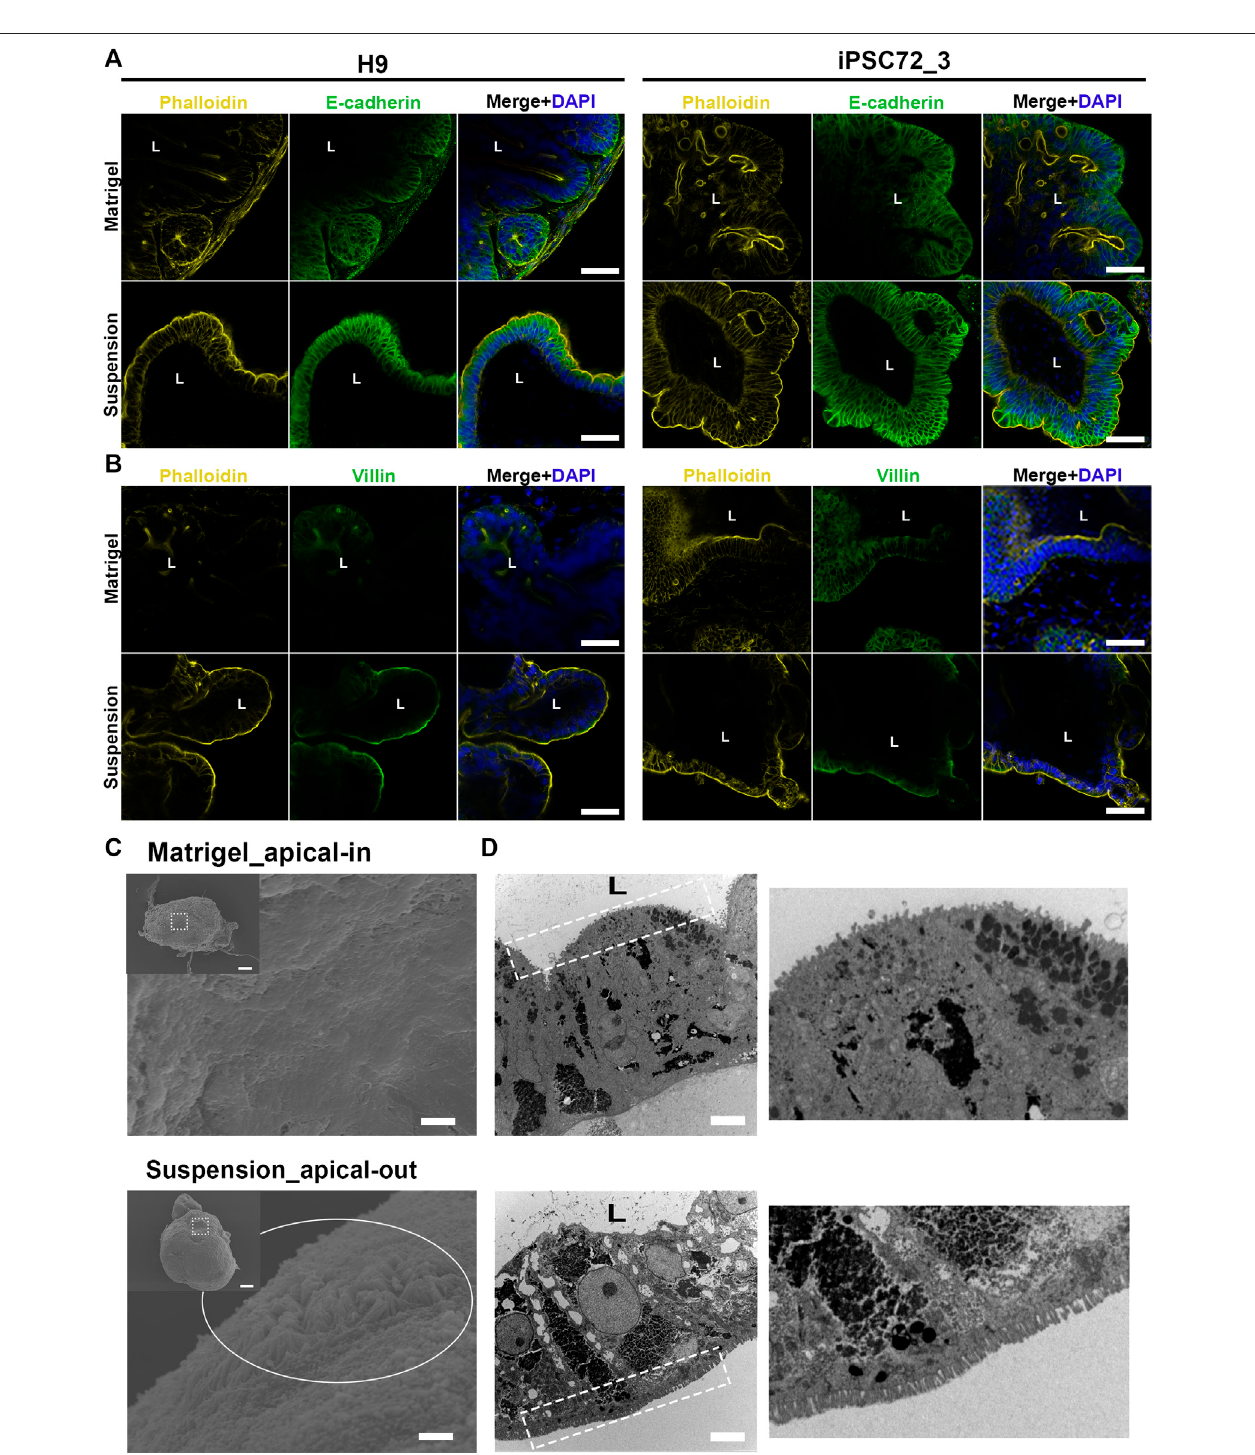
FIGURE 3 | Apico-basolateral organization of human intestinal organoids after 30 days in culture. (A) Fluorescent staining of embedded (top) and suspension (bottom)intestinalorganoidsforthebasolateralmarkerE-cadherin(green)andtheapicalmarkerPhalloidin(yellow)showsreversedpolarityofthesuspensionorganoids. TheleftpaneldemonstratesH9-derivedorganoidsandtherightoneiPSC72_3-derivedorganoids.Scalebar:100 μ m. (B) Theseresultswerecon fi rmedwithVillin(green) and Phalloidin (yellow) stainings that were found to co-express in the apical side of the organoids. The left panel demonstrates H9-derived organoids and the right one iPSC-derived organoids. Scale bar: 100 μ m. L: lumen. (C) SEM was performed in Matrigel embedded (top) and suspension (bottom) organoids showing the presence of microvilli (white circle) in the outer surface of the suspension organoids. Dashed squares represent the area magni fi ed in the corresponding image. Scale bars: 100 μ m (inset) and 2 μ m. (D) TEM indicates that microvilli (white dotted squares) face the lumen in Matrigel embedded (top) organoids, whereas in suspension (bottom) organoids, microvilli face the outer surface. On the right, magni fi ed images demonstrate the microvilli. Scale bars: 5 μ m.